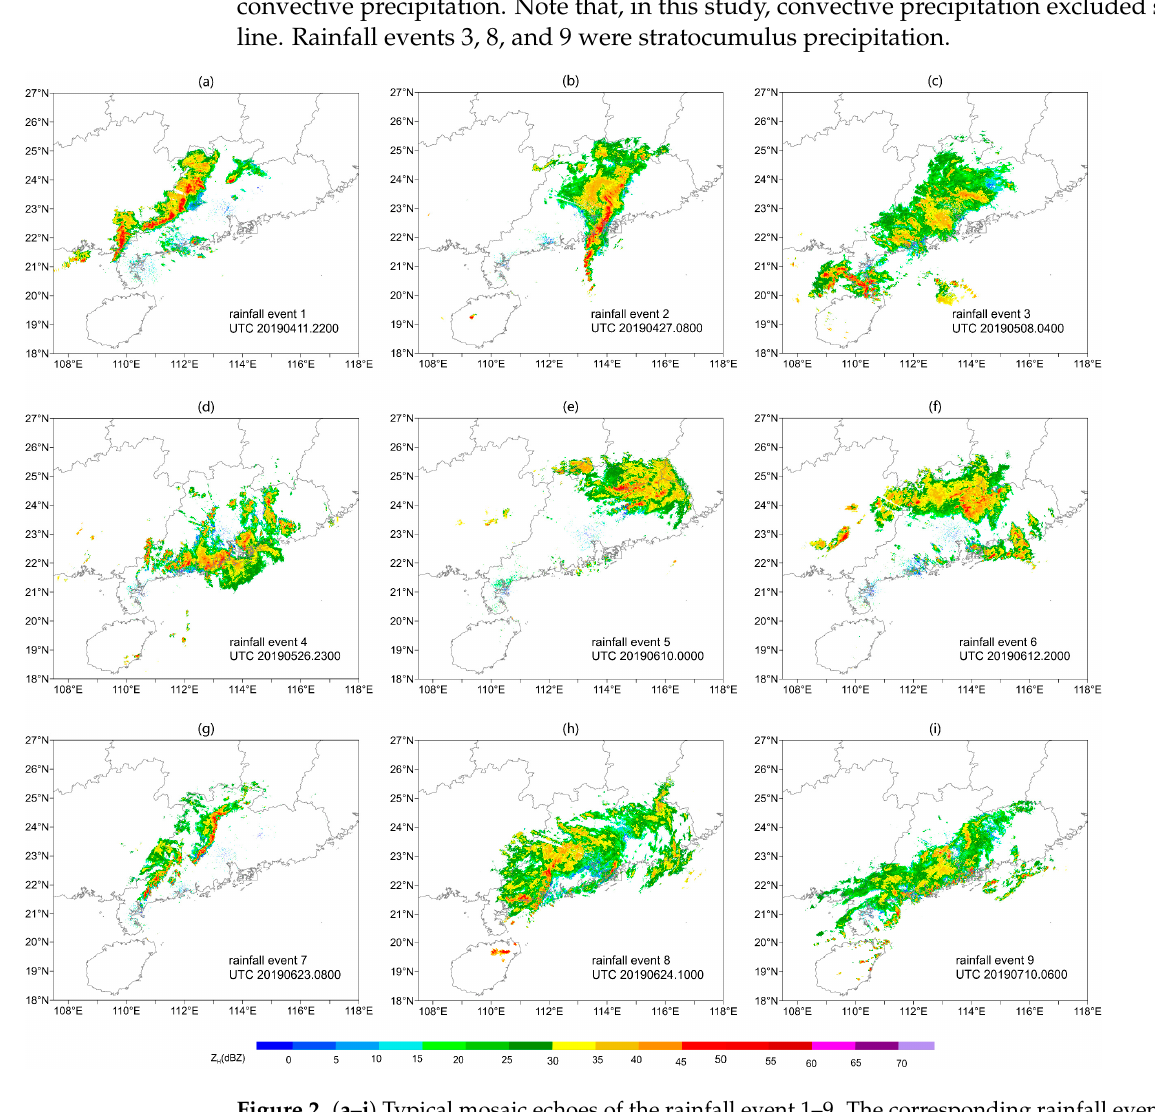
Table 2. Nine rainfall events used in this study.